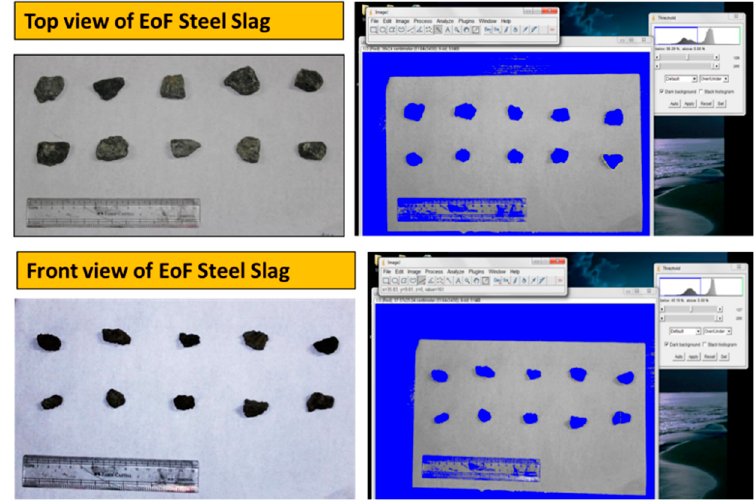
Figure 14. Top and front view of EOF steel slag and thresholded images.